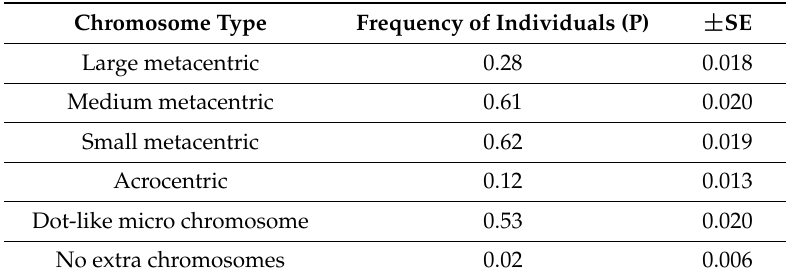
Table 2. Frequency of A. peninsulae individuals with different macro and micro B chromosomes in studied local